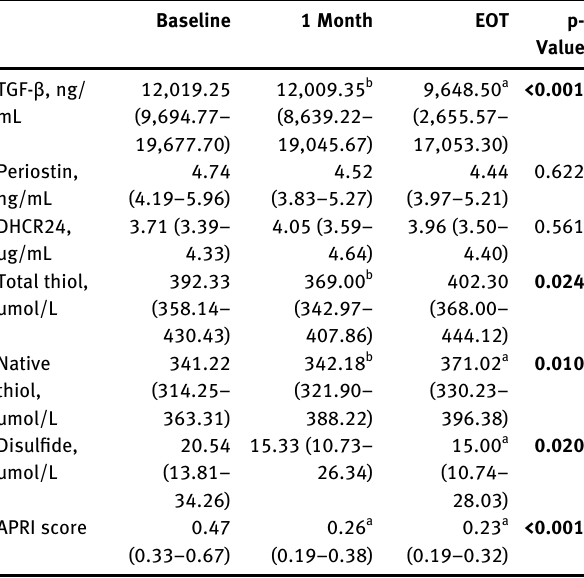
Table  : Changes in serum levels of periostin, TGF- β , DHCR  and thiol-disulphide hemostasis and the APRI score with direct-acting antiviral therapy on the study population (n= 